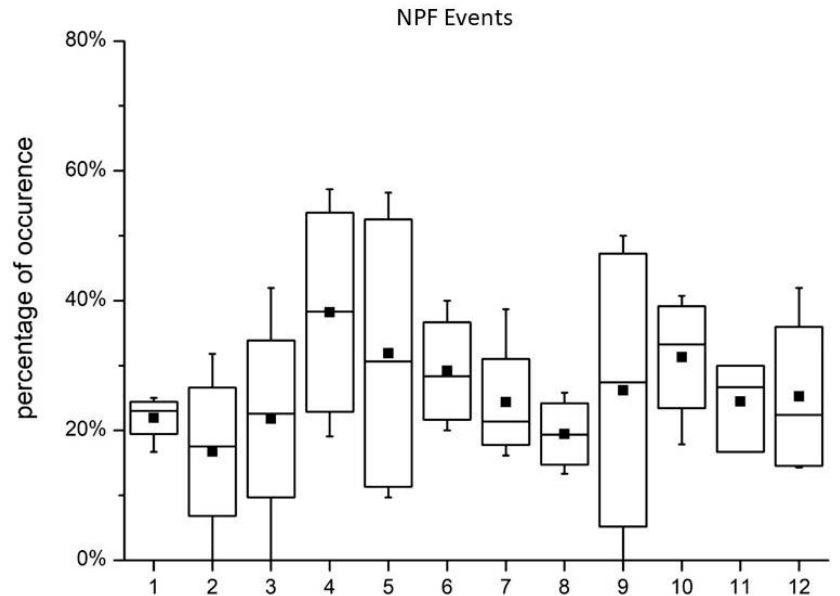
Figure 4. Seasonal average variation of NPF in percentage of occurrence at Finokalia station over the period 2013–2016. Whiskers represent the 5th and 95th percentiles, box edges are 25th and 75th percentiles, the line in the box is the median, and the solid square is the mean.